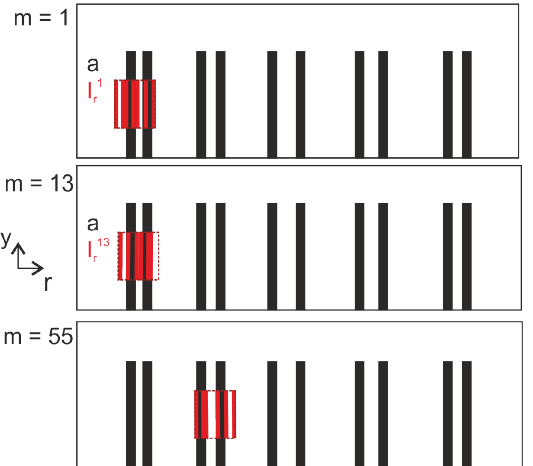
Figure 1. Exemplary specimen with defects shown as blackened stripes. A laser line array with twelve laser lines is used. Here y stands for the spatial vertical dimension and r stands for the spatial horizontal dimension. The illumination pattern differs for each measurement in the illuminated position and in the number of laser lines (indicated by the red area) which are switched on (randomly chosen). The dashed frame around the pattern indicates the covered illuminated area if all laser lines are switched